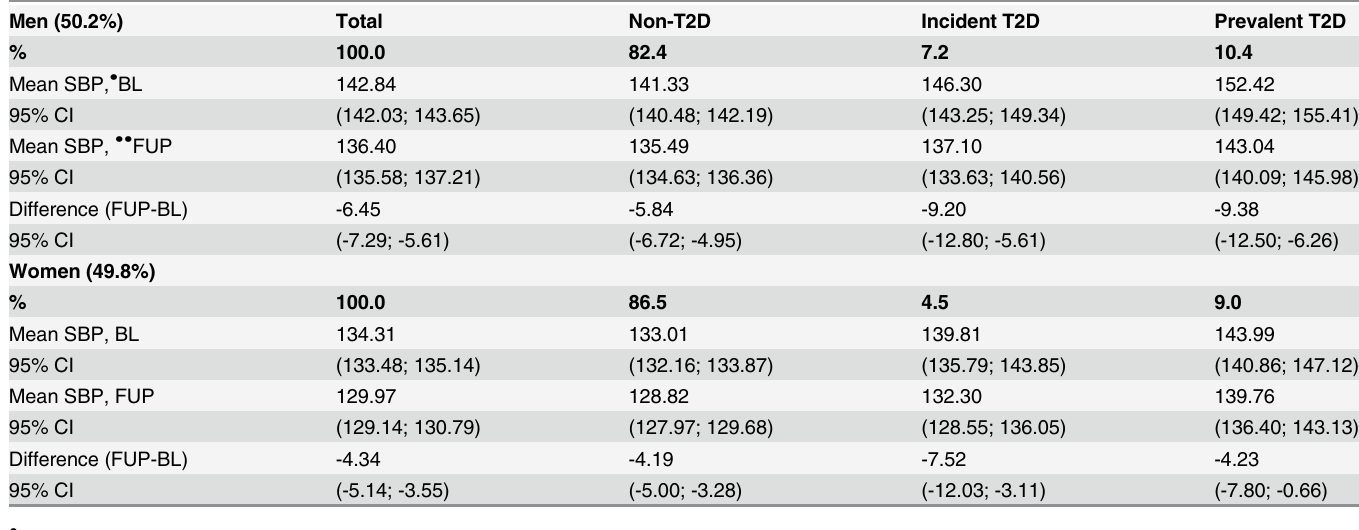
Table 3. Descriptive changes in systolic blood pressure stratified by sex and T2D